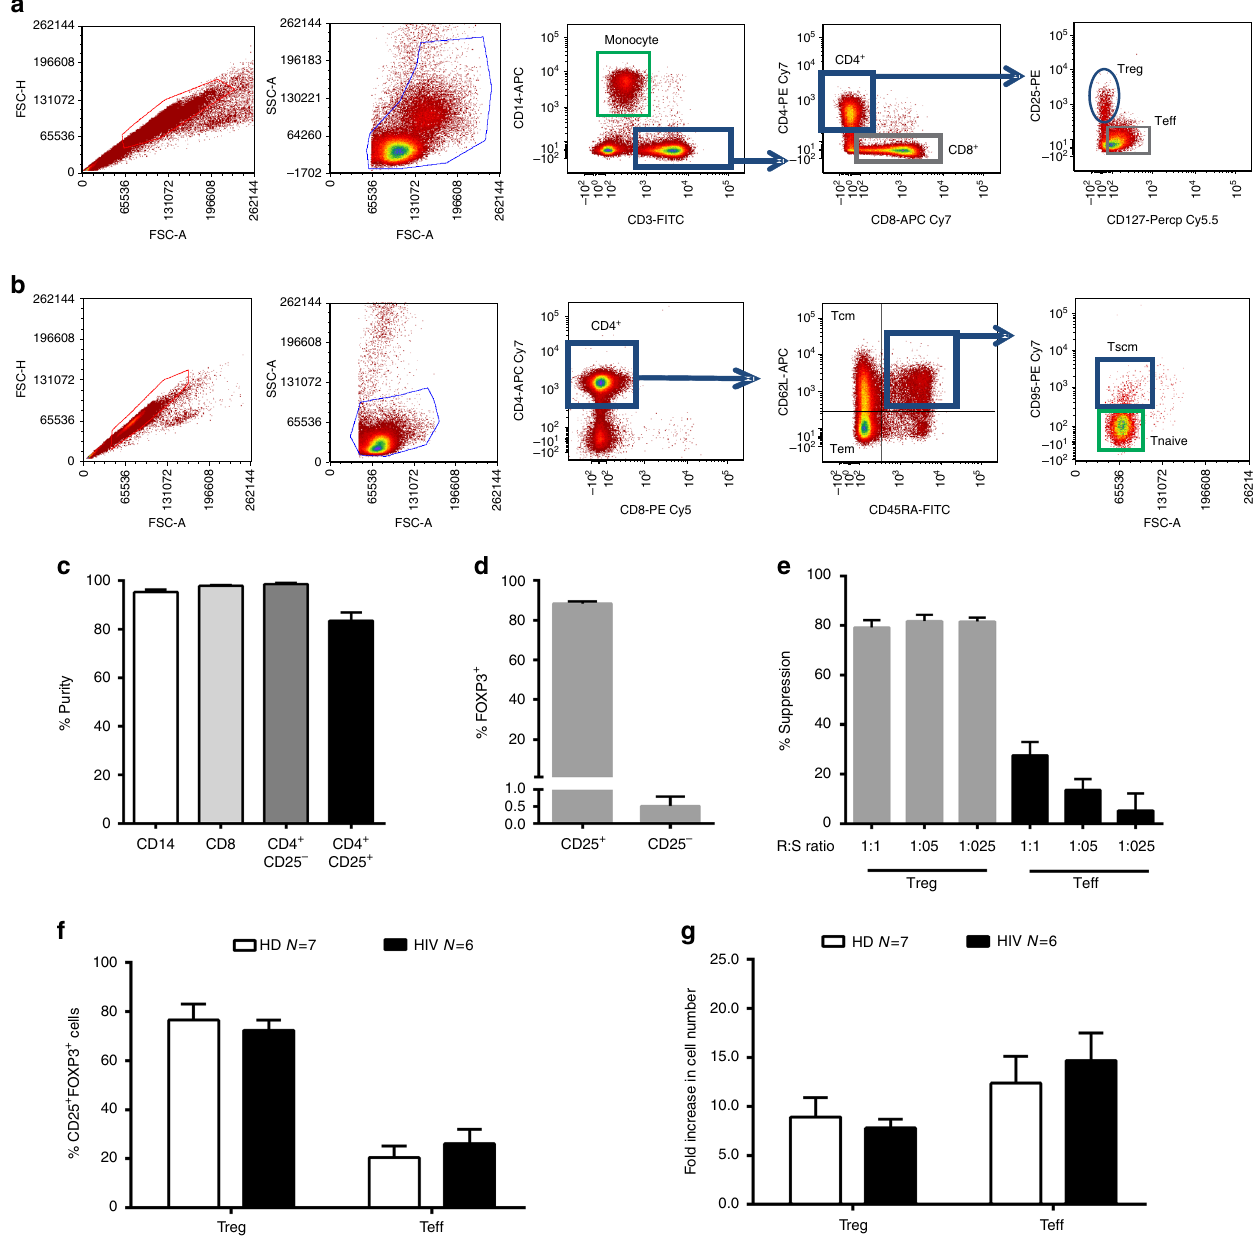
Fig. 2 Isolation of different T lymphocyte subsets and monocytes from HIV-1-infected patients under cART. a Representative FACS dot plots illustrating the sequential gating process used for the identi fi cation and cell sorting strategy of Treg (CD4 + CD25 + CD127 low), Teff (CD3 + CD4 + CD25 − ), monocytes (CD14 + ), and CD8 + cells; b FACS dot plots showing the sequential gating process used for the identi fi cation and cell sorting isolation of memory T cell subsets. Each memory cell subsets was identi fi ed by the following markers: CD4 + CD45RA + CD62L + CD95 + for T stem cell memory (Tscm); CD4 + CD45RA + CD62L + CD95 − for T-naïve; CD4 + CD45RA − CD62L + for T central memory (Tcm); and CD4 + CD45RA − CD62L − for T effector memory (Tem); c Assessment of the purity of the isolated monocyte (CD14 + ), CD8 + cells, CD4 + and CD4 + CD25 + cells puri fi ed by magnetic cell isolation, N = 6; d Percentage of FOXP3 + cells measured in CD25 + and CD25 − fraction after FACS sorting or magnetic cell isolation, N = 10; e Inhibition of proliferation (analyzed by fl ow cytometry for e-Fluor dilution and indicated as % Suppression vs. Responder alone) of anti-CD3/CD28 activated allogeneic Responder cells (R, CD4 + CD25 − ) and cultured in presence of different doses (Ratio R:S were 1:1, 1:05, and 1:0.25) of puri fi ed and expanded Treg and Teff cells (S), N = 10. f Relative percentage of FOXP3 + cells measured in Treg and Teff cells puri fi ed from the blood of HIV-infected patients or from HDs and expanded in culture for 10 days; g Fold increase in the amount Treg or Teff cells puri fi ed from the blood of HIV-infected patients or HD and expanded in culture for 10 days, N is indicated. In each panel, data are represented as Mean ± Treg, Teff, CD8 + T cells and monocytes puri fi ed by magnetic Treg and Teff cells from six patients (ID_25, 77, 76, 32, 38 and beads isolation from four patients (ID_25, 56, 63 and 76) (Fig. 2 71) (Fig. 2). HIV/ STAT5B transcripts were found in the puri fi ed and Supplementary Table 3). Moreover, the levels of the HIV/ Treg cells of six out of six patients and in Teff cells of two out six STAT5B and HIV/ BACH2 chimeric transcripts were quantita- donors (Fig. 3a, b). Moreover, in two out of two patients tested, tively measured by droplet digital (dd)-PCR on in vitro expanded we detected HIV/ STAT5B transcripts in Tcm cells (Fig. 3a),